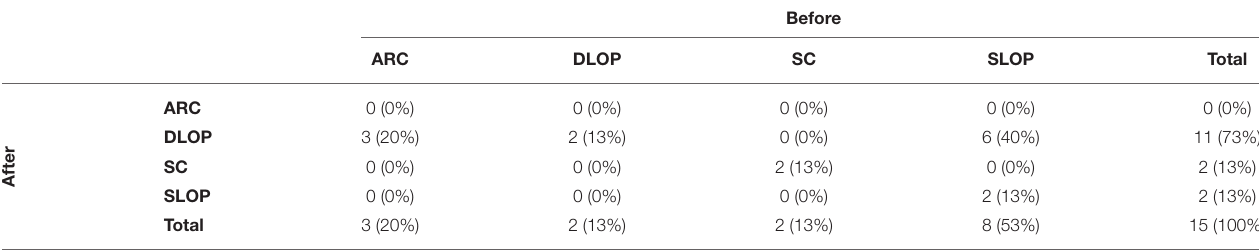
TABLE 2 | Contingency table of propulsion technique during the first and last session n(%). Before ARC DLOP SC SLOP Total ARC 0 (0%) 0 (0%) 0 (0%) 0 (0%) 0 (0%) DLOP 3 (20%) 2 (13%) 0 (0%) 6 (40%) 11 (73%) e r SC 0 (0%) 0 (0%) 2 (13%) t A f SLOP